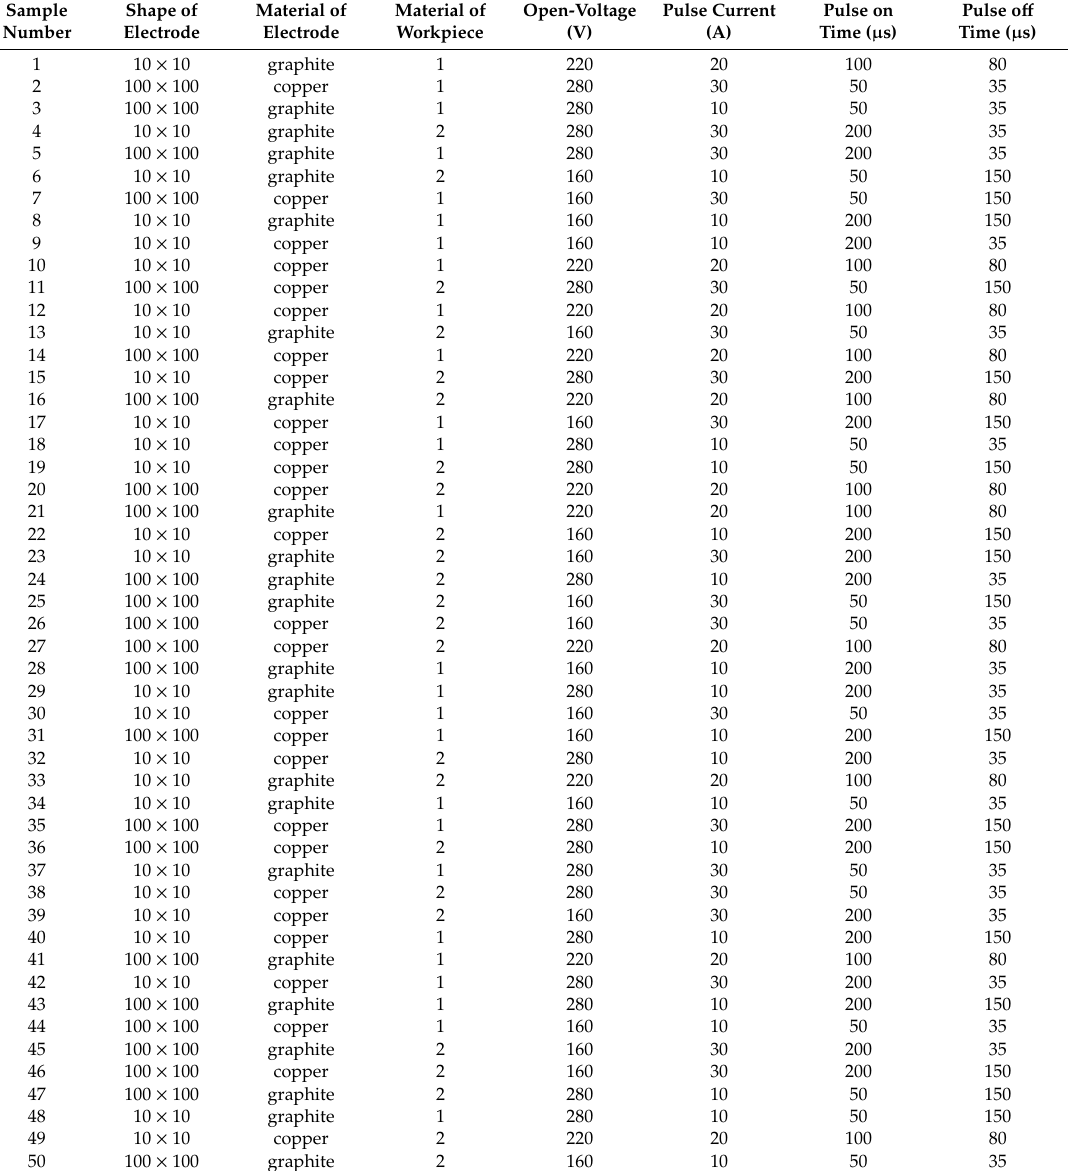
Table 2. Machining parameters used for individual runs of the